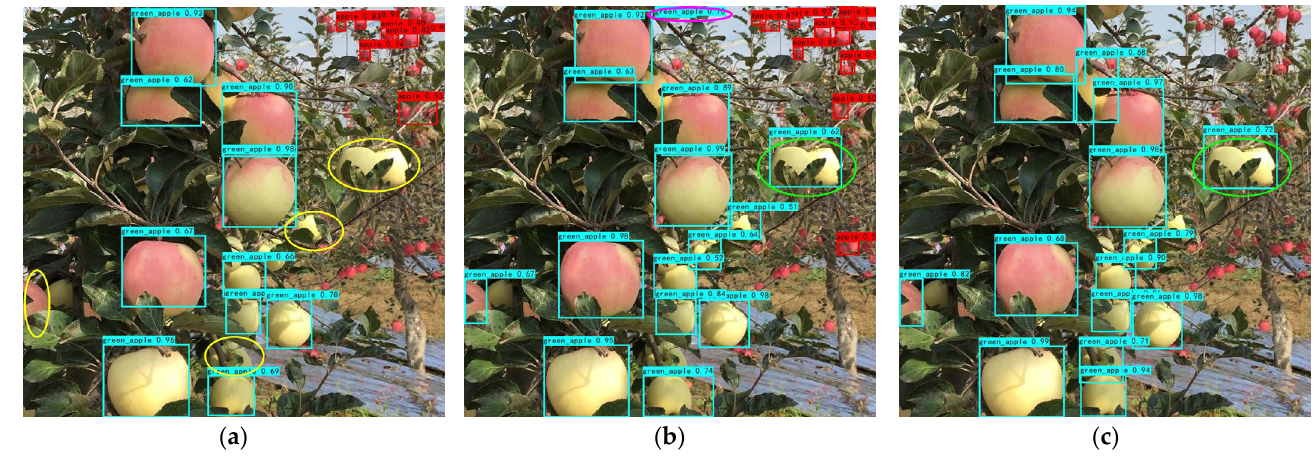
Figure 13. Experimental validation results of target screening: ( a ) The recognition effect of YOLO v4; ( b ) the recognition effect of Model 6; and ( c ) the recognition effect of Model 7 with the addition of the long-range target screening module.